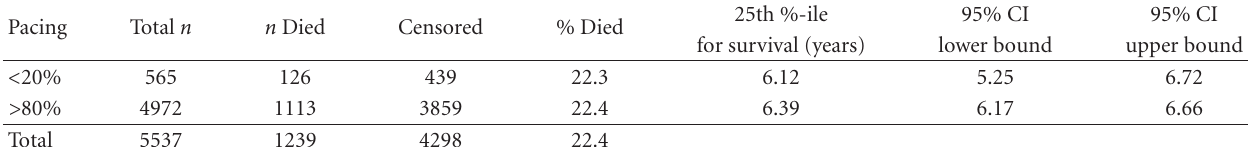
Table 4: Kaplan-Meier results for < 20% versus > 80% right ventricular